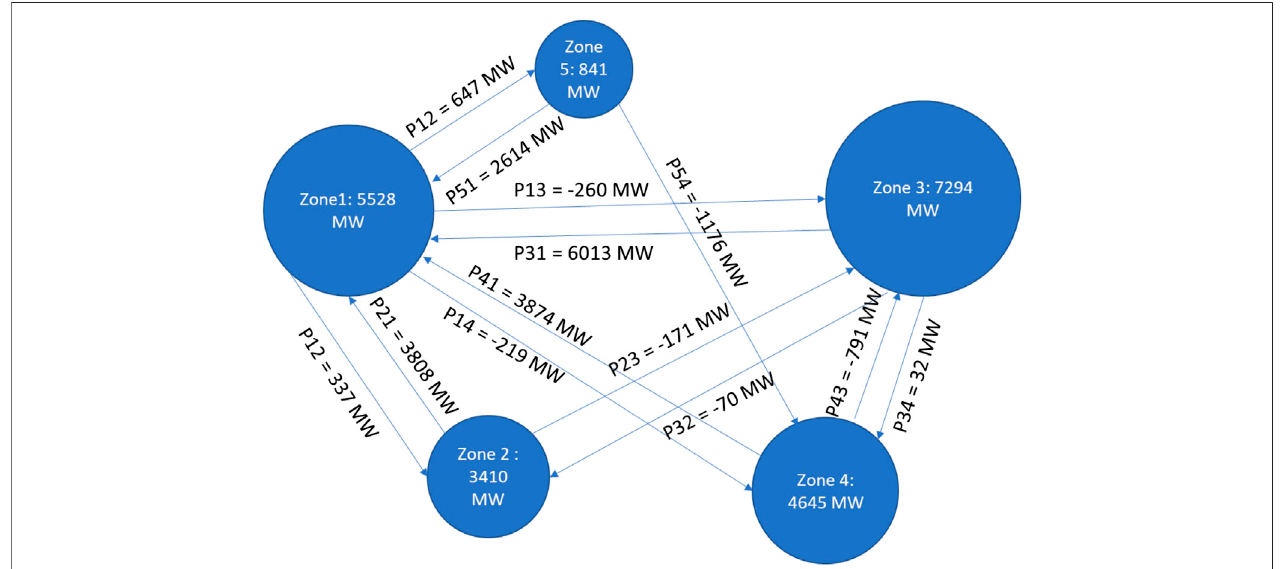
FIGURE 1 | Zonal model of the Polish 3120-bus system.